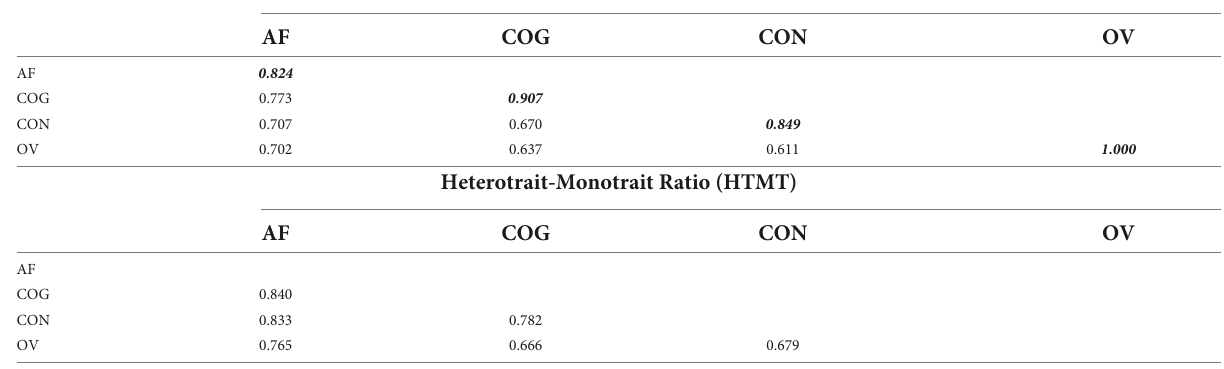
Fornell-Larcker Criterion